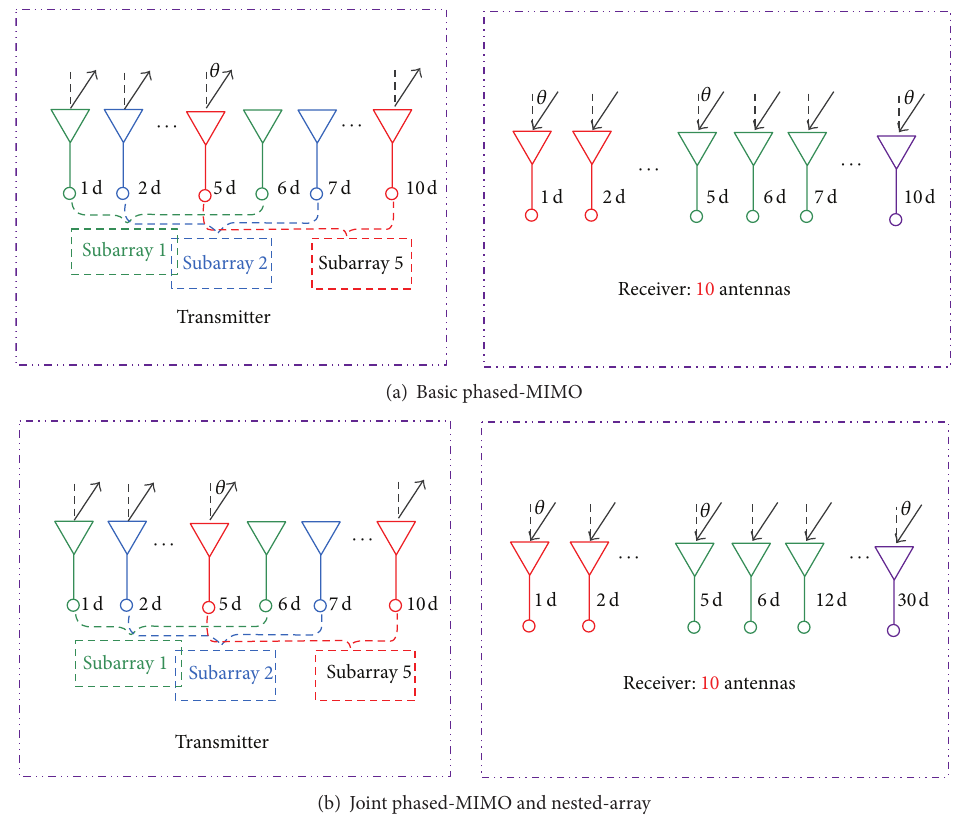
Figure 2: Comparisons between our proposal of joint phased-MIMO and nested-array and the basic phased-MIMO.